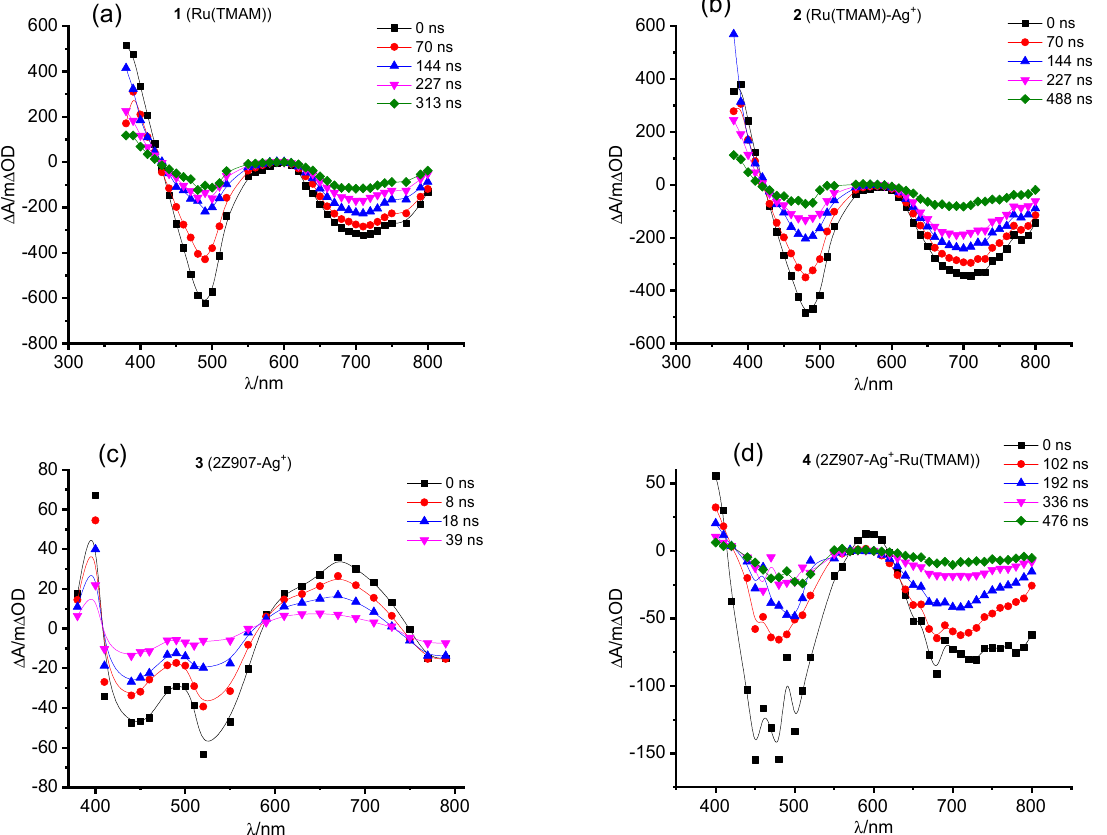
Figure 5. Transient absorption spectra (TAS) of ( a ) 1 Ru(TMAM) ( b ) 2 (Ru(TMAM)-Ag + ), ( c ) 3 (2907-Ag + ), and ( d ) 4 (2Z907-Ag + -(Ru(TMAM))) recorded in methanol upon 532 nm laser excitation.